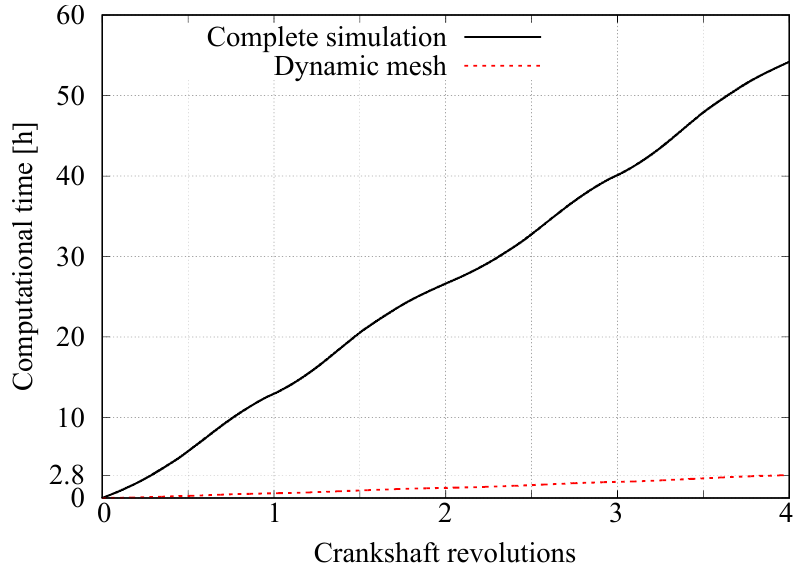
Figure 15. Time required for the complete and the dynamic mesh simulations as a function of the crankshaft